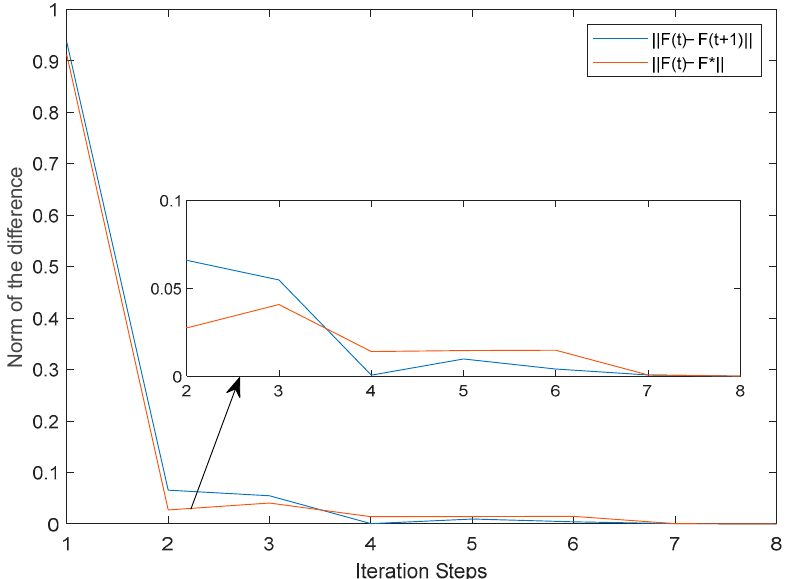
∗ (cid:107) during the iterative t − F t + 1 (cid:107) and (cid:107) F t − F